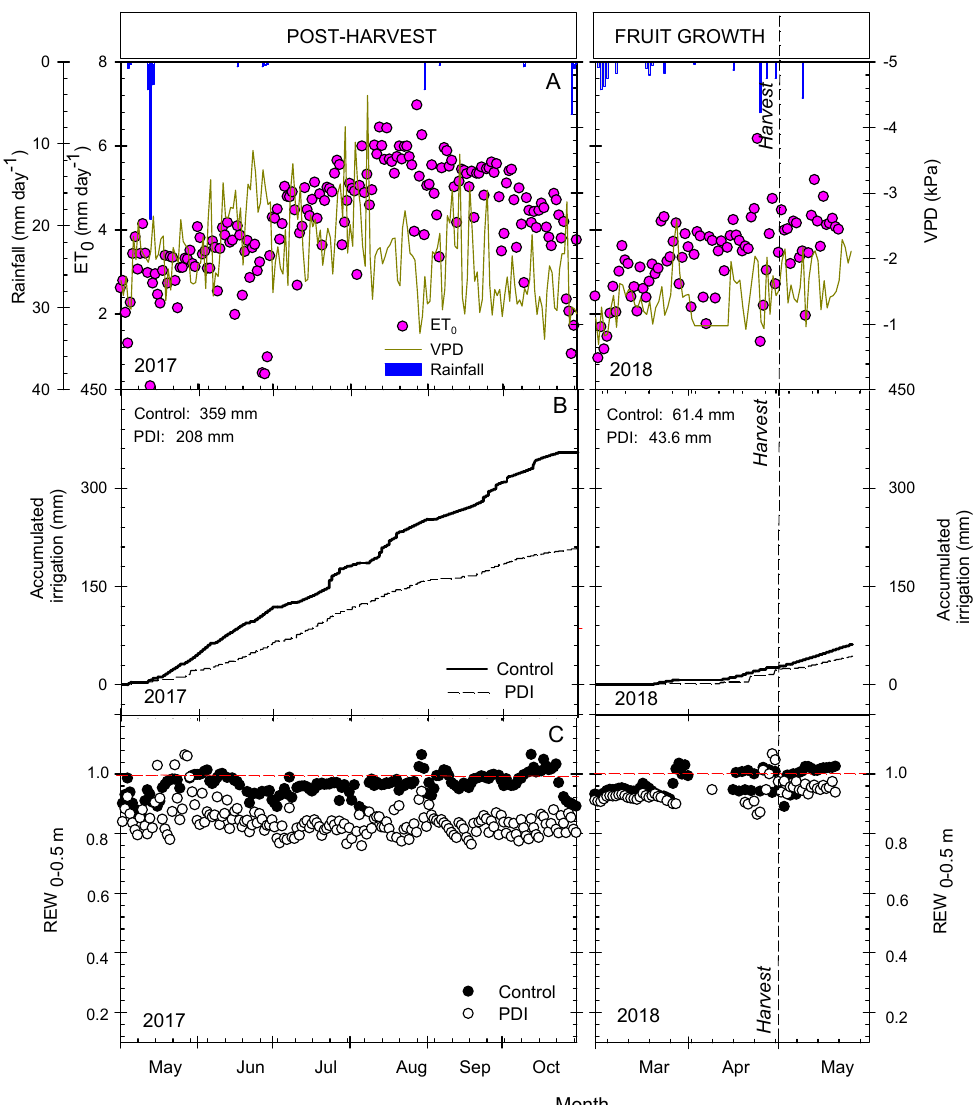
Figure 2. Seasonal evolution of ( A ) daily rainfall (mm), reference crop evapotranspiration (ET 0 , mm day − 1 ) and vapor pressure deficit (VPD, kPa), ( B ) accumulated irrigation (mm), and ( C ) relative extractable water (REW) in the 0–0.5 m soil profile in control ( ● ) and PDI (o) treatments. Values are means of four replicates.